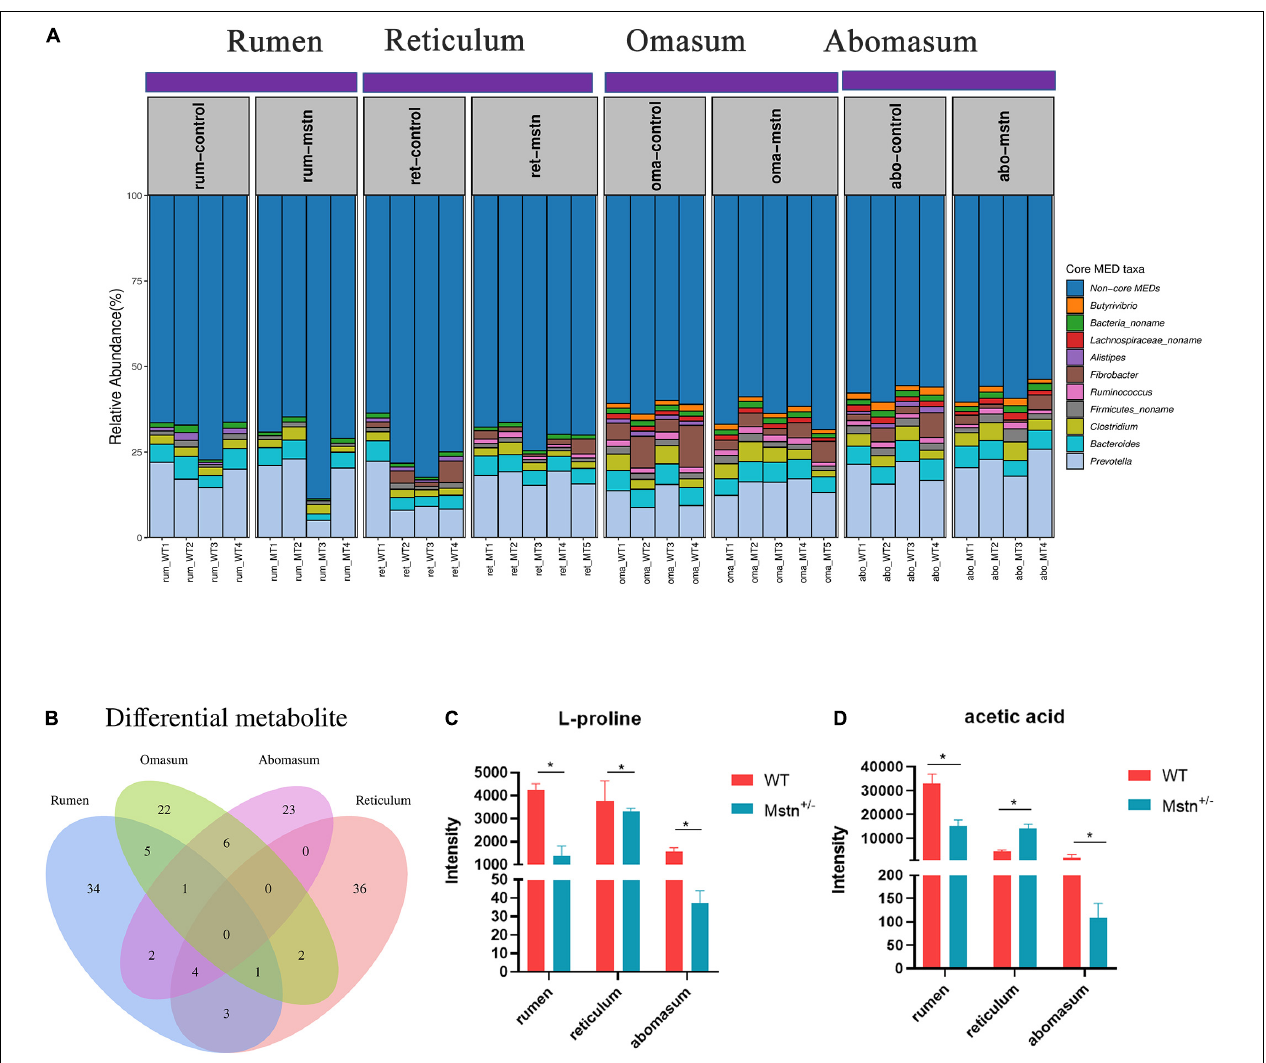
FIGURE 4 | The core microbiota and different metabolite throughout the rumen, reticulum, omasum, and abomasum between the MSTN + / − and WT cattle. Relative abundances of minimum entropy decomposition (MED) nodes identified as core members (taxa present at greater than 1% abundance in more than 50% of samples) (A) . The Venn diagram of the shared and unique metabolites throughout the four stomach compartments (B) . L-proline (C) and acetic acid (D) intensity between MSTN + / − and WT cattle in the rumen, reticulum, and abomasum. * p <